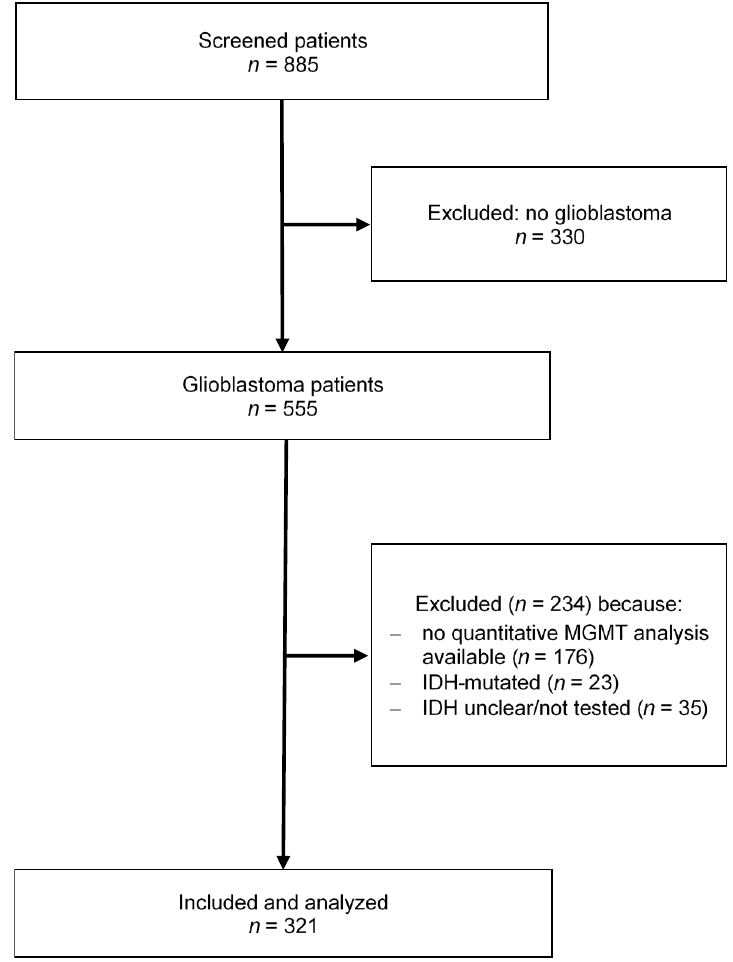
Figure 1. Flowchart illustrating patient selection.